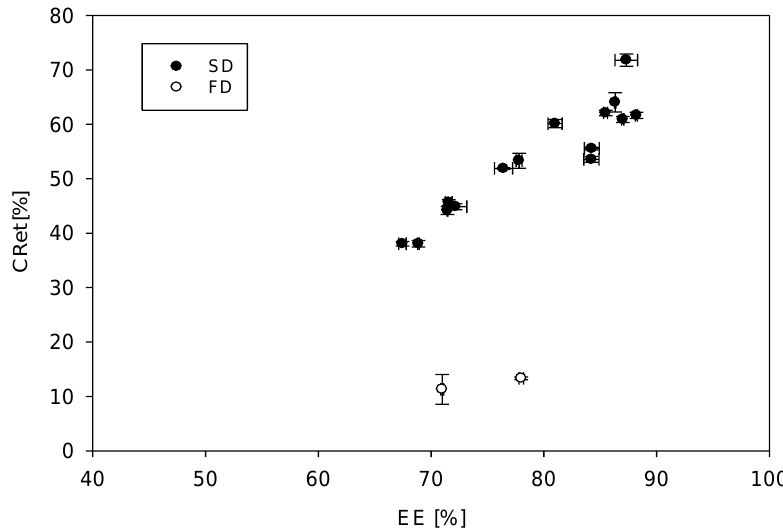
Figure 6. Carotenoid retention (CRet) in carrot concentrate powders after storage (91 days, 35 °C, air) as a function of the encapsulation efficiency (EE). Each data point represents the mean of a triplicate analysis. Error bars fall below the size of the symbols in some cases.